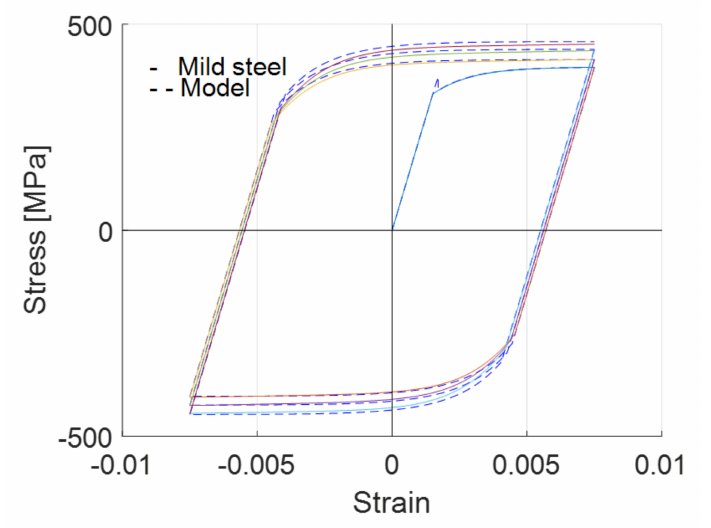
Figure 7. Stress–strain curves for calibration of the combined hardening coefficients. Consider the case where the strip has the thickness t (=20 mm), the length L (=2480 mm), and the width W (=100 mm). The radius R of the rolls is 85 mm. The roll spacing D is 150 mm. The strip is taken as flat and free of residual stress. The upper roll carriage has an inclination angle θ of 0.1 ◦ and the roll intermesh at the next to the last roll p 8 ranges from − 1.2 mm to 0.8 mm. Note that the value of the roll intermesh is positive when the gap between the